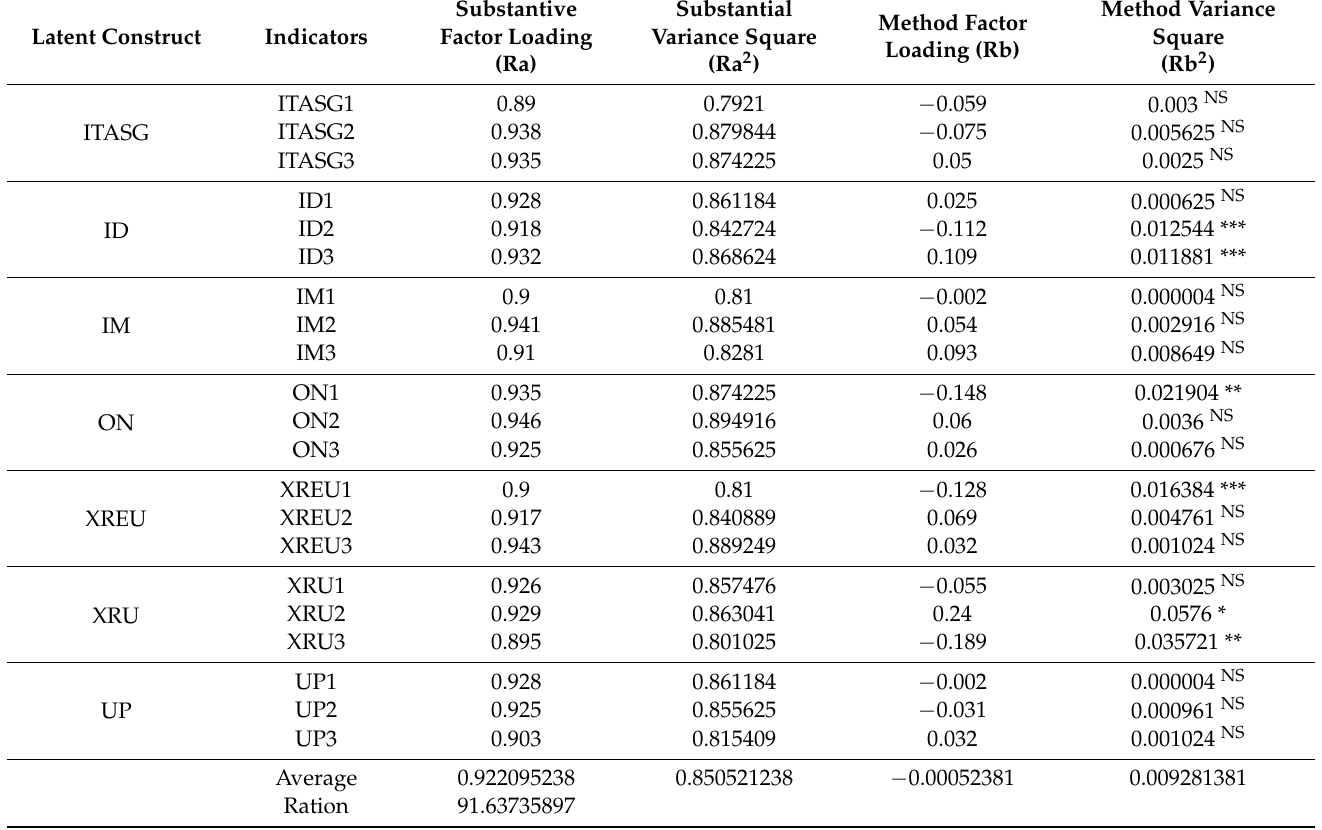
Table 3. Common method